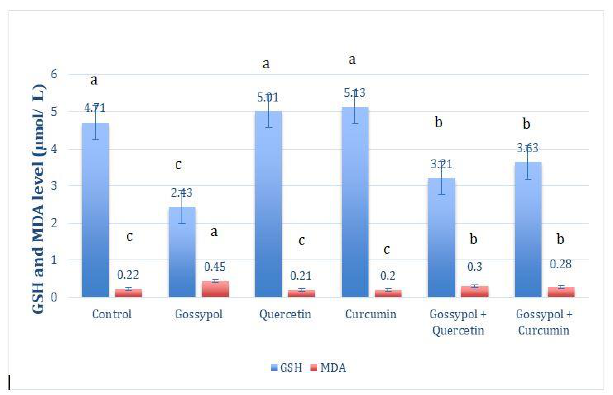
Fig. 1: The effect of treatment with gossypol, quercetin, curcumin, gossypol + quercetin and gossypol + curcumin on GSH and MDA levels in serum (mean ± standard error). Similar letters indicate no significant differences between groups at (P > 0.05), while different letters indicate a significant difference between groups at (P < 0.05).